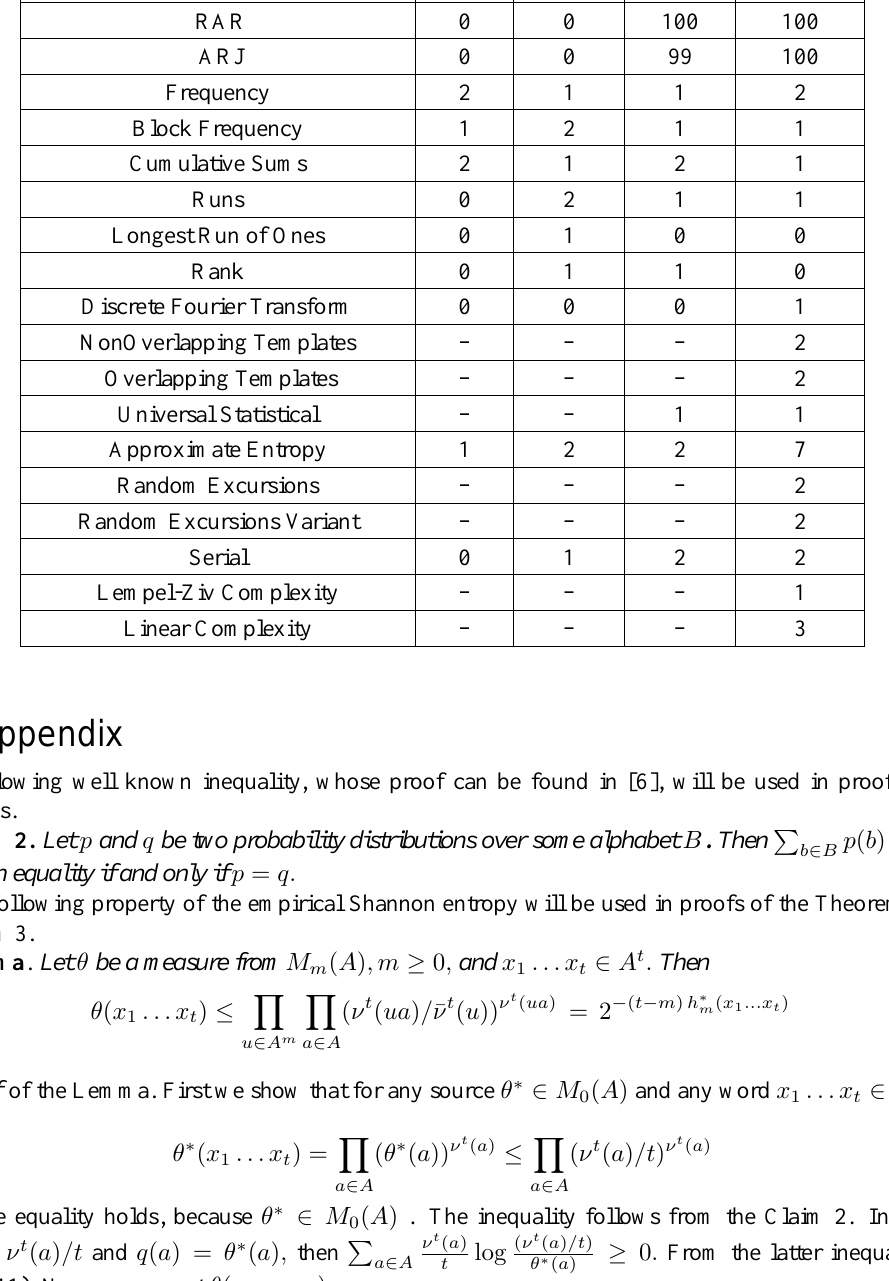
Tab. 1: Number of files generated by PRNG RANDU and recognized as non-random for different tests. Name of test / Length of file (in